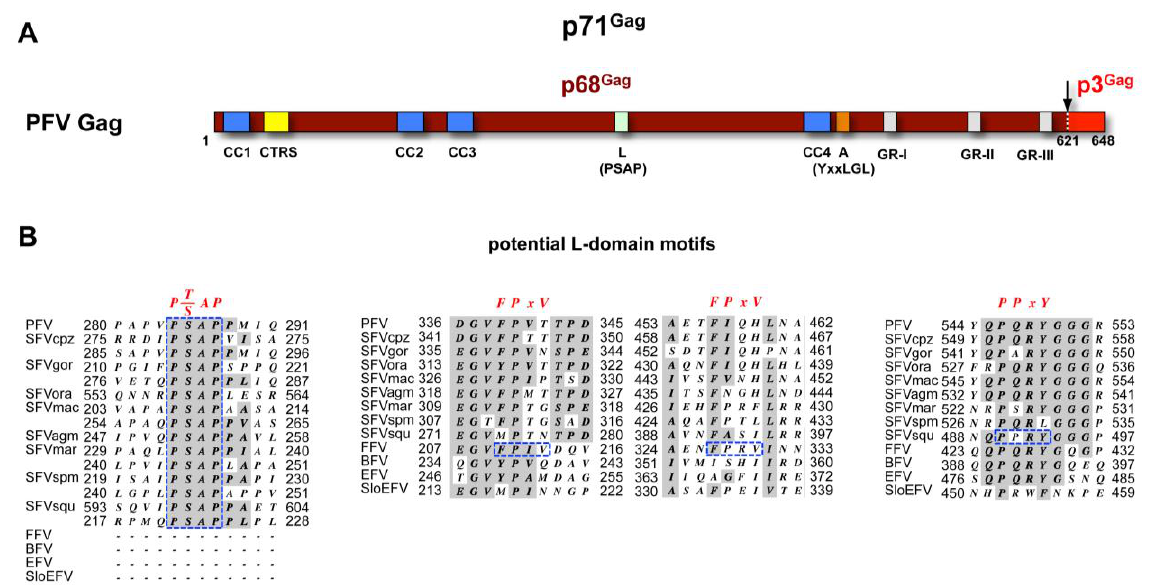
Figure 2. Foamy virus Gag. ( A ) Schematic organization of PFV Gag protein. The primary cleavage site within the p71 Gag precursor resulting in processing into p68 Gag and p3 Gag cleavage products is indicated by an arrow. CC1-4: putative coiled-coil motifs; CTRS: cytoplasmic targeting and retention signal; L: late assembly domain (PSAP); A: assembly domain (LYxxLGL); GR-I-III: glycine-arginine rich boxes I to III. Numbers indicate amino acid position in PFV Gag; ( B ) Sequence alignment of putative L-domain motifs of different FV species. Consensus L-domain motifs are shown in red on top. FV sequences matching the L-domain motif consensus are marked in dashed, blue boxes. Sequences used for alignment were retrieved from GenBank. PFV: prototype foamy virus, human foamy virus Y07725.1; SFVcpz: chimpanzee simian foamy virus, NC001364.1; SFVgor: gorilla simian foamy virus, HM245790.1; SFVora: orangutan simian foamy virus, AJ544579.1; SFVmac: macaques simian foamy virus, NC010819.1; SFVagm: African green monkey simian foamy virus, NC010820.1; SFVmar: common marmoset simian foamy virus, GU356395.1; SFVspm: spider monkey foamy virus, EU010385.1; SFVsqu: squirrel monkey foamy virus, GU356394.1; FFV: feline foamy virus, Y08851.1; BFV: bovine foamy virus, NC001831.1; EFV: equine foamy virus, NC_002201.1; SloEFV: sloth endogenous foamy virus, [23]. Complete Gag sequences were aligned using MacVector software and Gonnet matrix and sequence surrounding putative FPxV or PPxY L-domain motifs extracted. For PSAP L-domain motifs the core consensus motif together with four N- and C-terminal flanking amino acids extracted and manually aligned. Sequence identities are shaded in grey. Numbers indicate amino acid position in the respective full-length